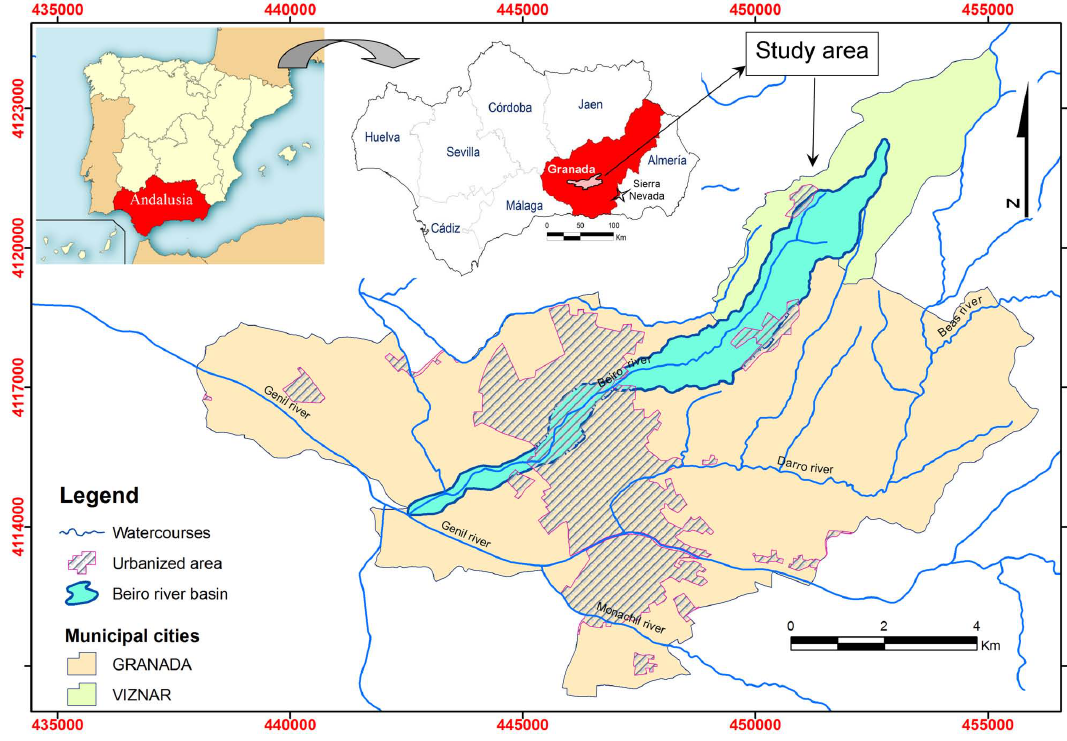
Fig. 1. Geographical setting of the study zone. Coordinate Reference System: UTM zone 30 European Datum 50.